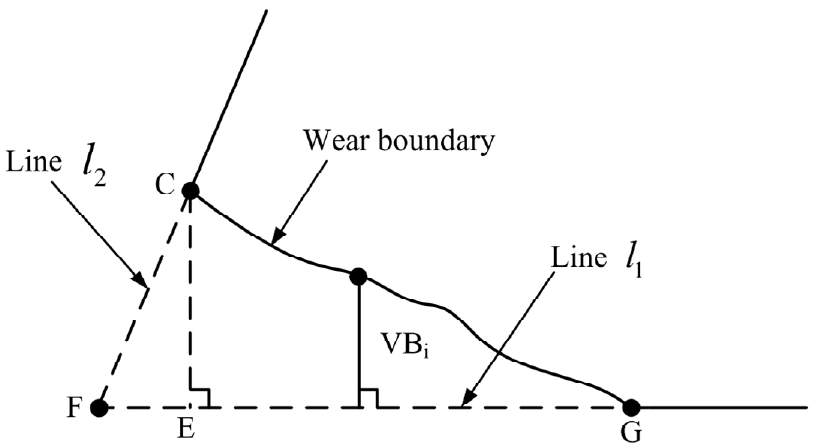
Figure 10. Schematic of tool wear extent extraction.